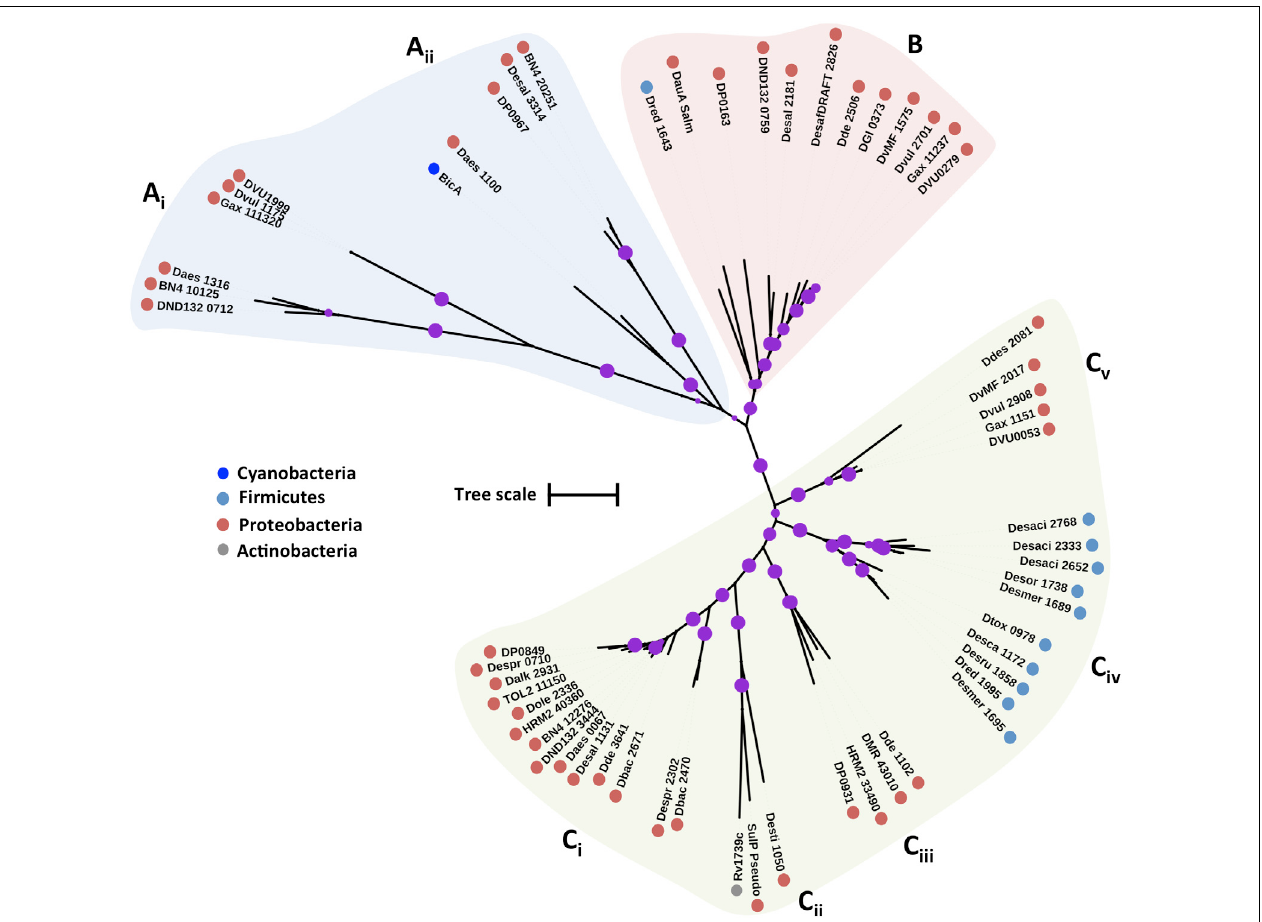
FIGURE 1 | Maximum likelihood phylogenetic tree of SulP protein sequences. The different protein clades are marked with different colored backgrounds and given a letter label (A–C) , while separate protein groupings are denoted by subscript numbering (i, ii, etc.). Phylum level classification of the protein sequences is indicated by colored dots next to the accession number (see Supplementary Table 1 for organism information). Reference sequences: BicA, bicarbonate transporter (UniProt: Q14SY0), DauA_Salm, dicarboxylic acid transporter (ACY88617), Rv1739c, sulfate transporter (SulP_Mt), SulP_Pseudo, sulfate transporter (PA1647). Bootstrap values ≥ 50% are indicated by purple dots on each branch where the size of the dot is proportional to the value. The scale bar represents 1 substitution per amino acid